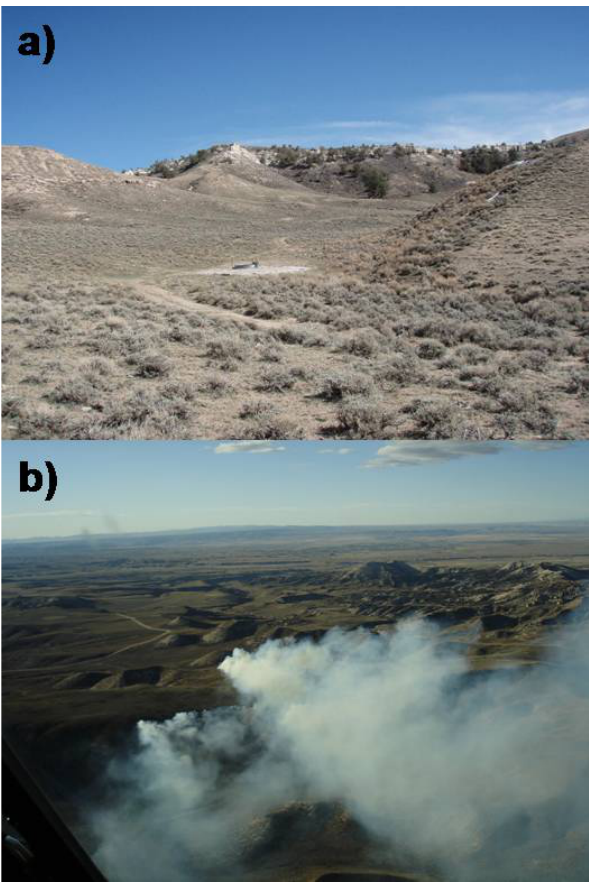
Fig. 1. Photographs of the RF03 prescribed burn: (a) location prior to the burn (courtesy of Kristi Bulock) and (b) smoke plume as viewed from the C-130 aircraft (courtesy of David